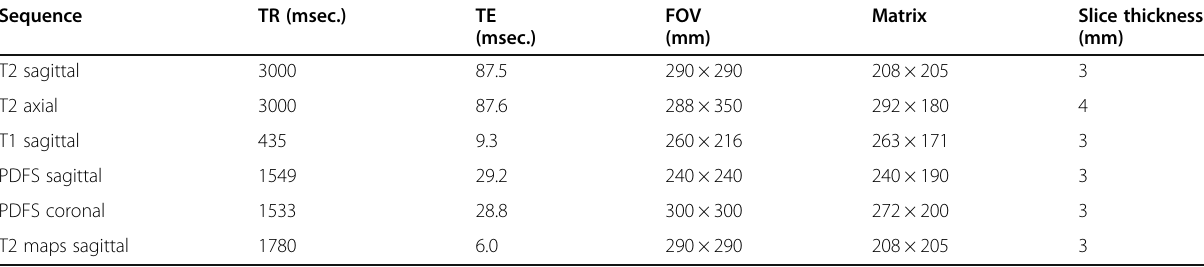
Table 1 MRI sequences used in the study Sequence TR (msec.)